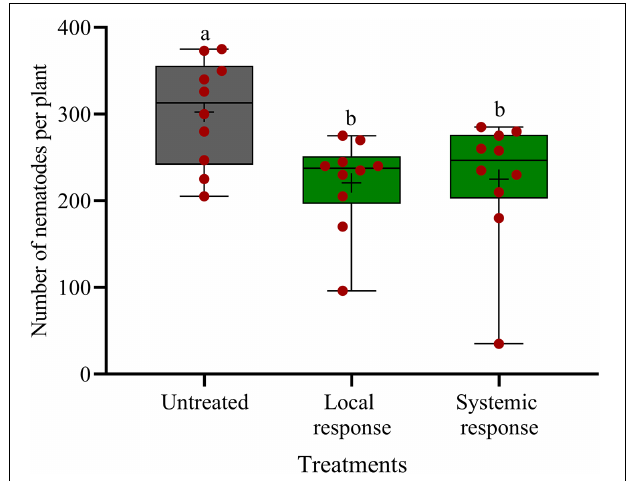
FIGURE 5 | Systemic and local effects of the oxo-C14-HSL-producing Ensifer meliloti ExpR + strain on the invasion of Pratylechus penetrans into soybean roots. Different letters indicate significant differences among treatments in Tukey’s test ( n = 10). Mean numbers of invaded nematodes in roots are shown as (+) for each treatment, while the medians are shown as